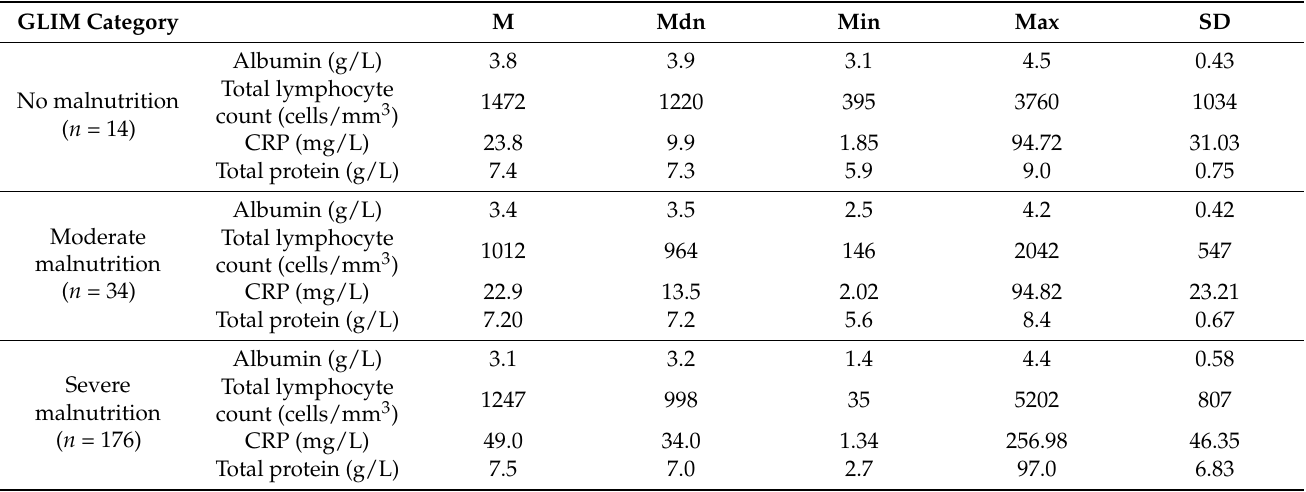
Table 5. Summary of biochemical data used in correlation with the stage of malnutrition of HNC patients.